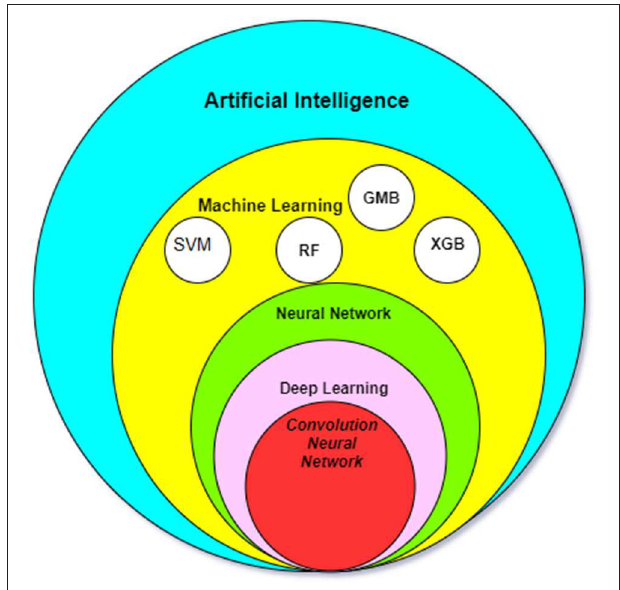
FIGURE 1 | The relationship between the most common AI methods in medicine. SMV, Support Vector Machine; RF, Random forest algorithm; GBM, Gradient Boosting Machines; XGB,